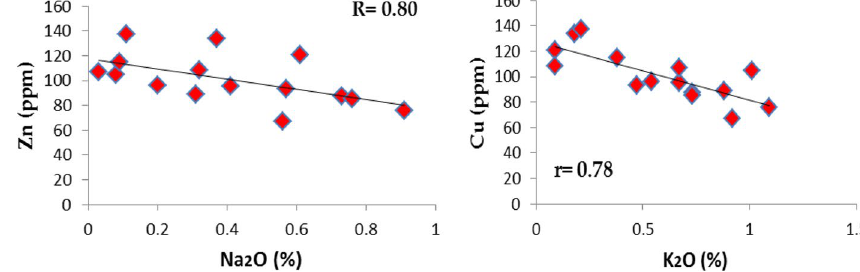
Fig. 5 Plot of some selected trace elements Cu, Zn, versus